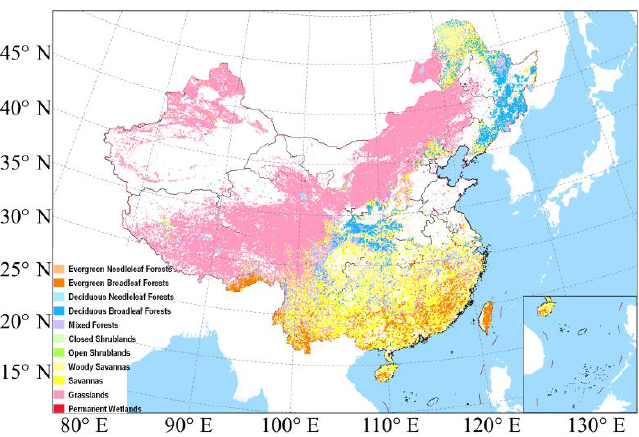
Figure 1. Spatial distribution of MODIS natural vegetation types.